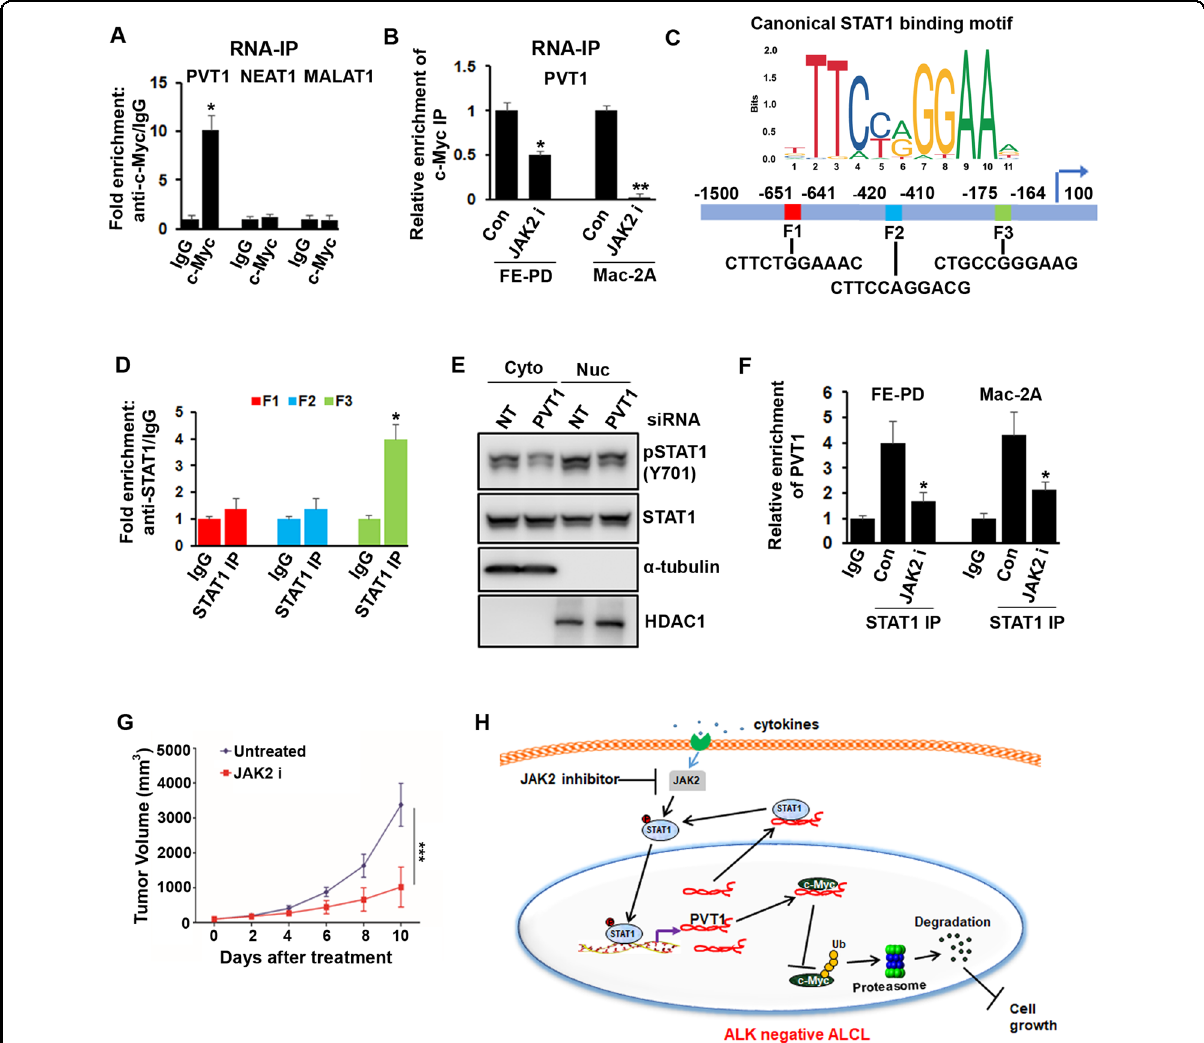
Fig. 2 Involvement of STAT1 and PVT1 lncRNA feedback loop in ALK-negative ALCL. A RNA-IP was performed in the lysate of FE-PD cells using c-Myc antibody and QRT-PCR was performed using speci fi c primers for PVT1, NEAT1, and MALAT1 lncRNAs (* P < 0.05). B RNA-IP was performed in the Mac-2A and FE-PD lysate treated with fedratinib and QRT-PCR was performed using PVT1 primers (* P < 0.05, ** P < 0.01). C Schematic diagram of STAT1-binding motif and three potential STAT1 responsive elements (F1, F2, and F3) in the PVT1 promoter region. D The enrichment of STAT1 on PVT1 promoter (F1, F2, and F3) was detected by chromatin immunoprecipitation assay (* P < 0.05). E Mac-2A cells were incubated with non-target (NT), or speci fi c PVT1 siRNA for 72 hours before analysis of indicated proteins in the cytoplasmic and nuclear fractions assessed by western blotting. F QRT-PCR of STAT1 enriched PVT1 lncRNA following immunoprecipitation with anti – STAT1 antibody in the presence and absence of JAK2 inhibitor fedratinib (* P < 0.05). G In vivo fedratinib treatment decreased tumor volume as compared to the untreated group (*** P < 0.001). H Schematic diagram of JAK2 regulating ALK-negative ALCL cell growth via STAT1-PVT1-Myc signaling